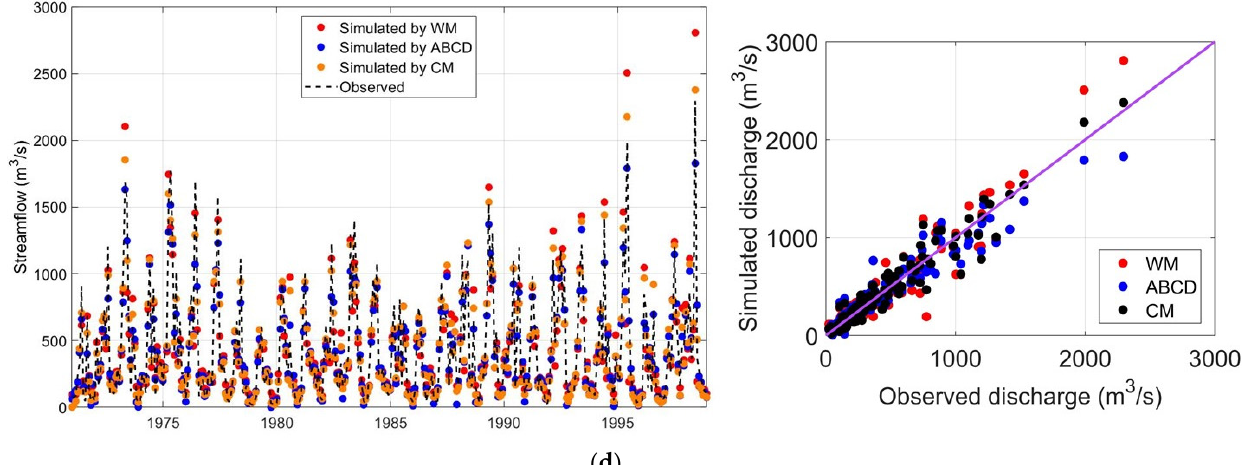
Figure 5. ( a ) Simulated and measured monthly runoff processes at QZ station. ( b ) Simulated and measured monthly runoff processes at JH station. ( c ) Simulated and measured monthly runoff processes at LX station. ( d ) Simulated and measured monthly runoff processes at WR station.